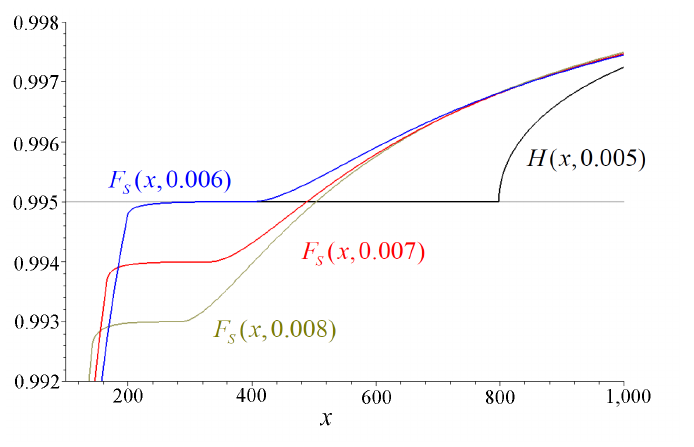
Figure 13: Plots of the cdf’s F S ( x , 0.005 + ε ) for ε ∈ { 0.001, 0.002, 0.003 } and H ( x , 0.005) in Example 3.